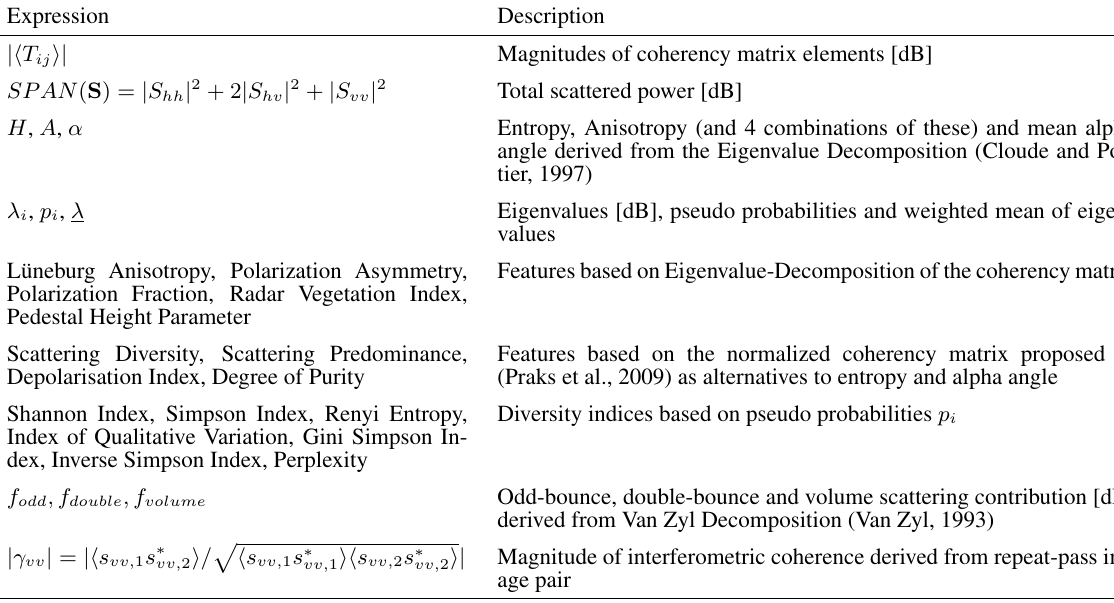
Table 1. Polarimetric and interferometric features extracted to build a high-dimensional representation of PolInSAR data. Extracted features from L- and S-band images are projected to ground-range geometry on a common 1 m × 1 m raster.